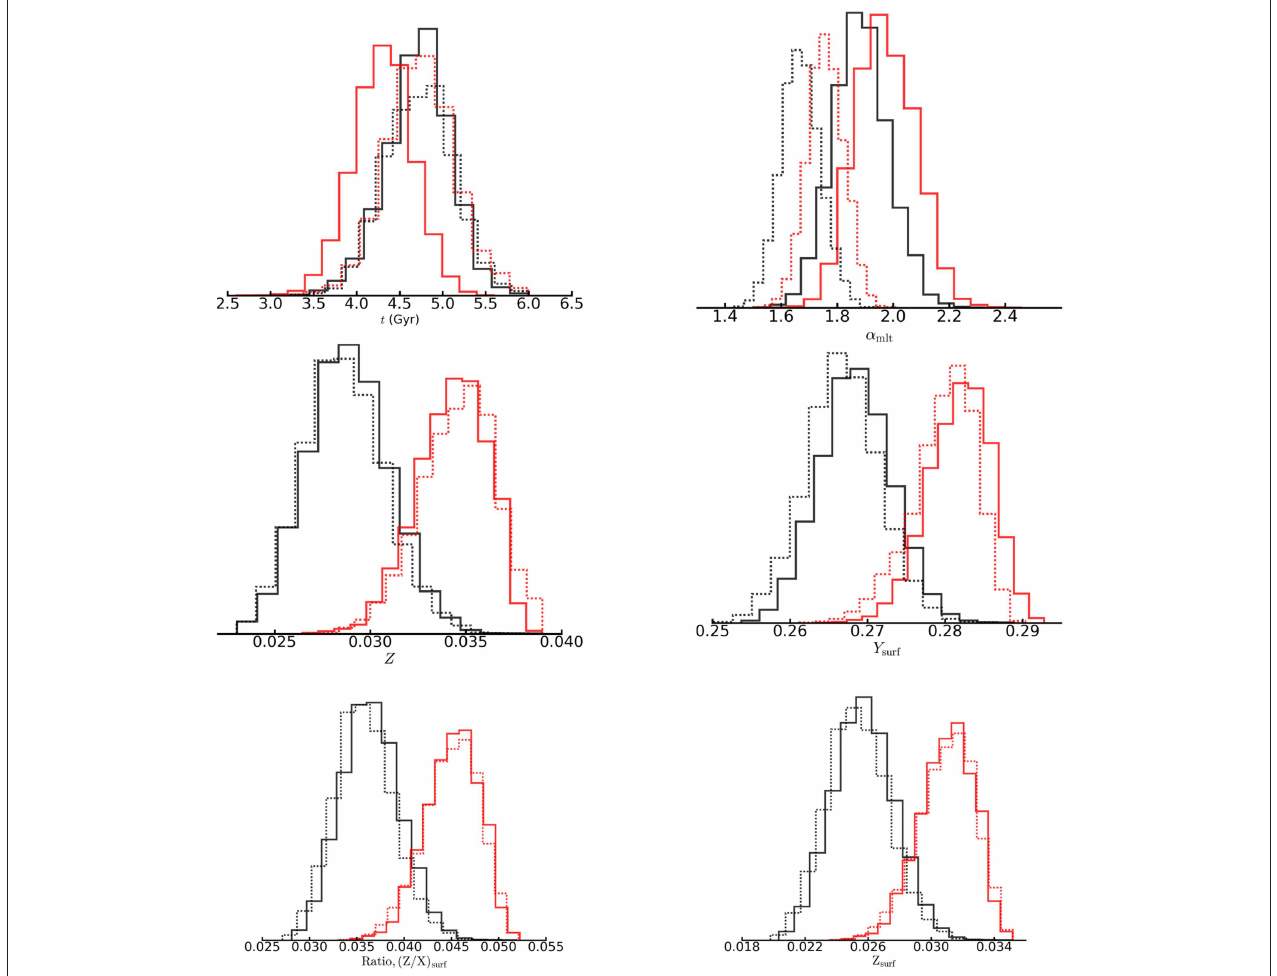
FIGURE 2 | Histograms represent stellar parameter posterior PDFs obtained using different grids (Grid A in red and Grid B in black) and observational constraints (Run I as solid lines and Run II as dashed lines).